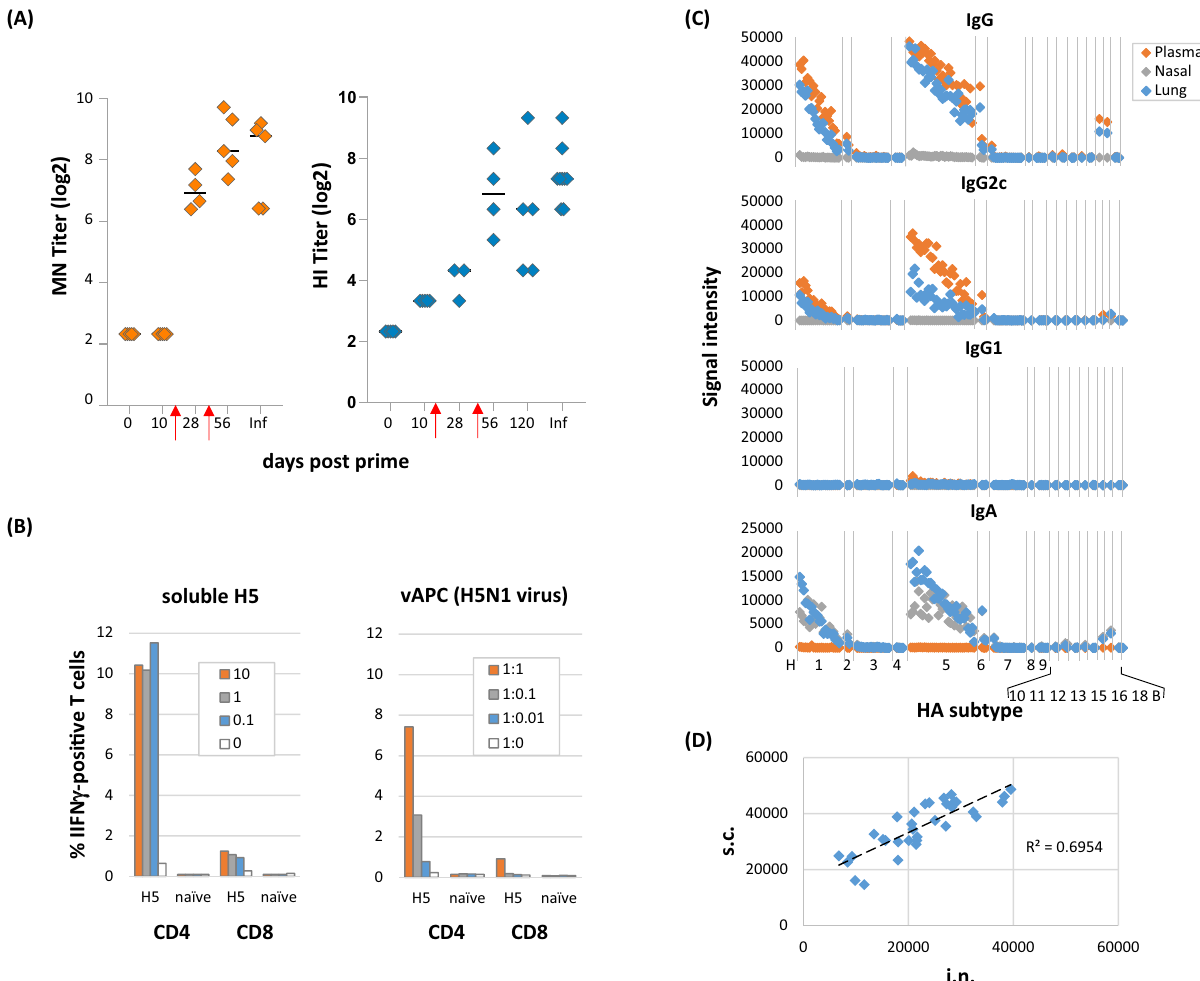
Figure 7. Further characterization of H5/IVAX-1. Mice were administered trimerized H5 antigen from A/Viet Nam/1203/04 in combination adjuvant CpG/MPLA/AddaVax (“IVAX-1”). ( A ) Virus microneutralization (MN) and hemagglutination (HI) assays. Five C57Bl/6 mice were immunized and boosted on days 14 and d42 (red arrows), and plasma samples collected at different time points tested for neutralization against reassortant H5N1 virus. Plasma from H5N1-infected mouse (Inf) was used as a positive control. Neutralizing titers against H5N1 virus increase with boosting. ( B ) IVAX-1 preferentially stimulates CD4 + T cells compared to CD8 + T cells. T cell recall assays were performed by incubating splenocytes from H5/IVAX1-immunized mice with recall antigens as either soluble H5 protein (monomers from Sinobiological) at different concentrations (mg/mL), or syngeneic vAPCs (splenocytes exposed for 1 h to reassortant H5N1 influenza virus) at different splenocyte : vAPC ratios. Cultures were incubated overnight, and the proportions of IFNγ-positive CD4 and CD8 cells determined using ICS. ( C ) H5/IVAX-1 administered by intranasal (i.n.) route induces IgG2c in lung and plasma, and IgA in lung and nasal turbinate washes. B6 mice were administered H5 trimers in IVAX-1 adjuvant via the i.n. route on